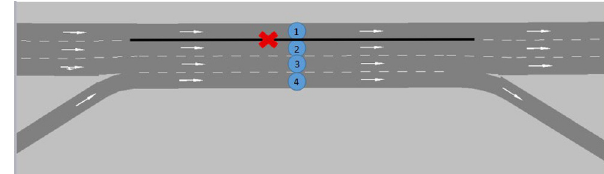
Figure 10 Lane-changing isolation scheme for weaving area (Scenario III)